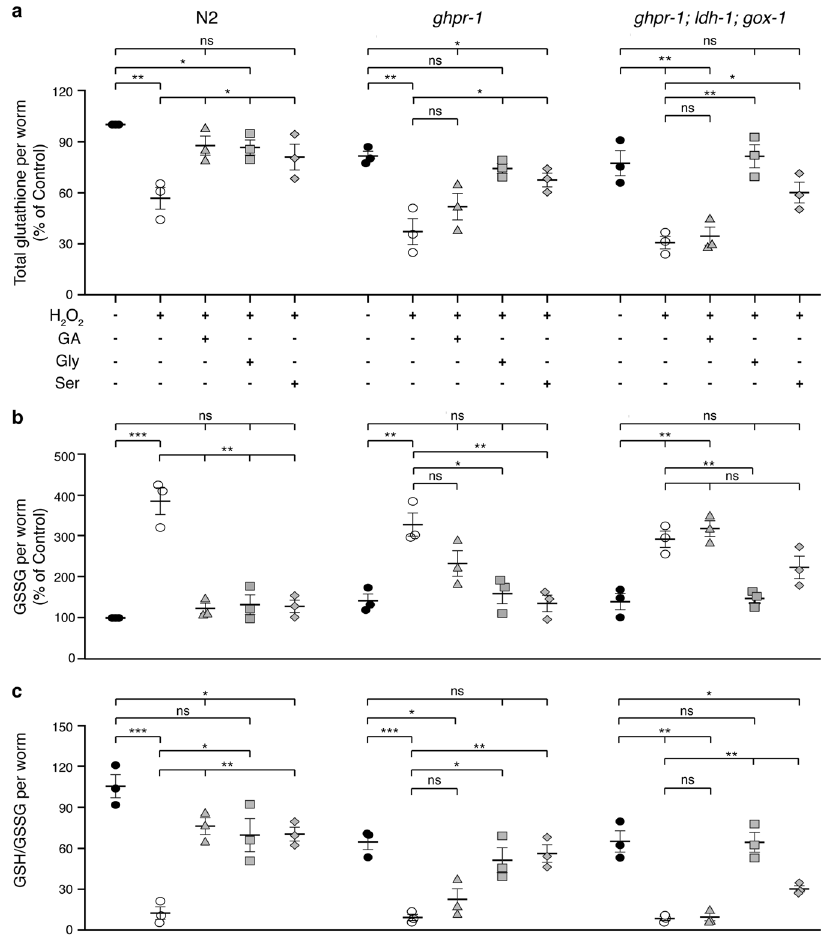
Fig. 6 Glycine and L -serine but not glycolate can ameliorate the antioxidant capacity of C. elegans mutants unable to metabolize glycolate to glyoxylate. a Total glutathione (GSH + GSSG) levels, b GSSG levels, and c ratio of GSH to GSSG in wild type (N2), single ( ghpr-1 ), and triple ( ghpr-1, ldh-1, gox-1 ) mutant animals exposed to 100 mM H 2 O 2 and supplemented or not with 10 mM glycolate (GA), 100 μ M glycine or 500 μ M L -serine. Values were determined after 3 days of treatment and normalized to number of worms. Error bars represent standard error of the mean ( n =